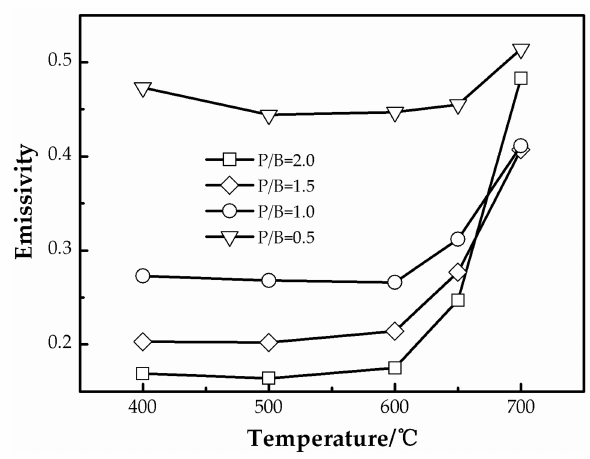
Figure 8. Average IR emissivity (8–14 µ m) of polysiloxane/Al coatings after heat